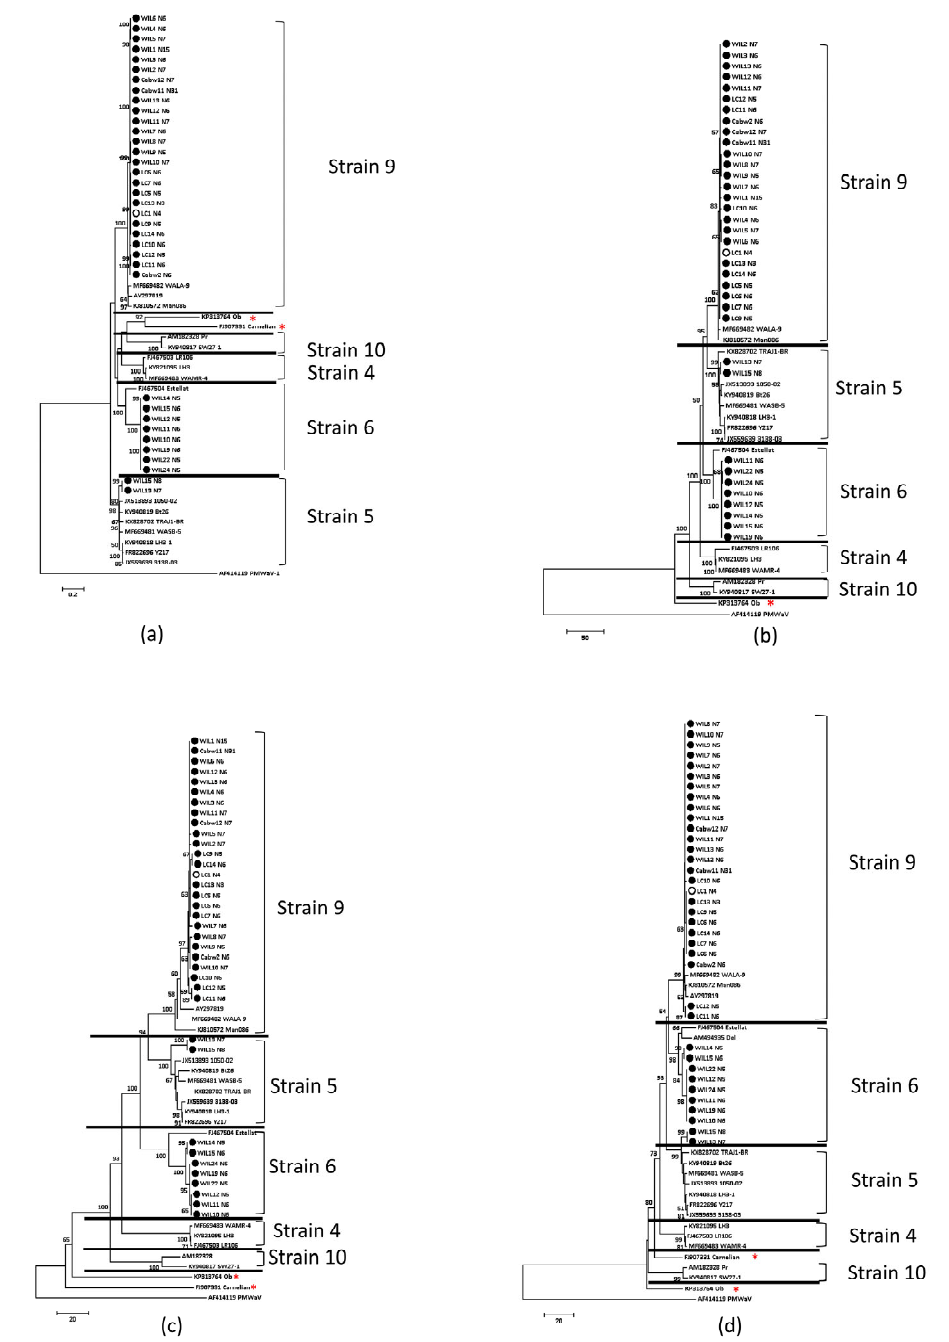
Figure 5. Neighbour-joining phylogenetic trees of grapevine leafroll-associated virus 4 (GLRaV-4) detected by metagenomic high-throughput sequencing and isolates from the GenBank